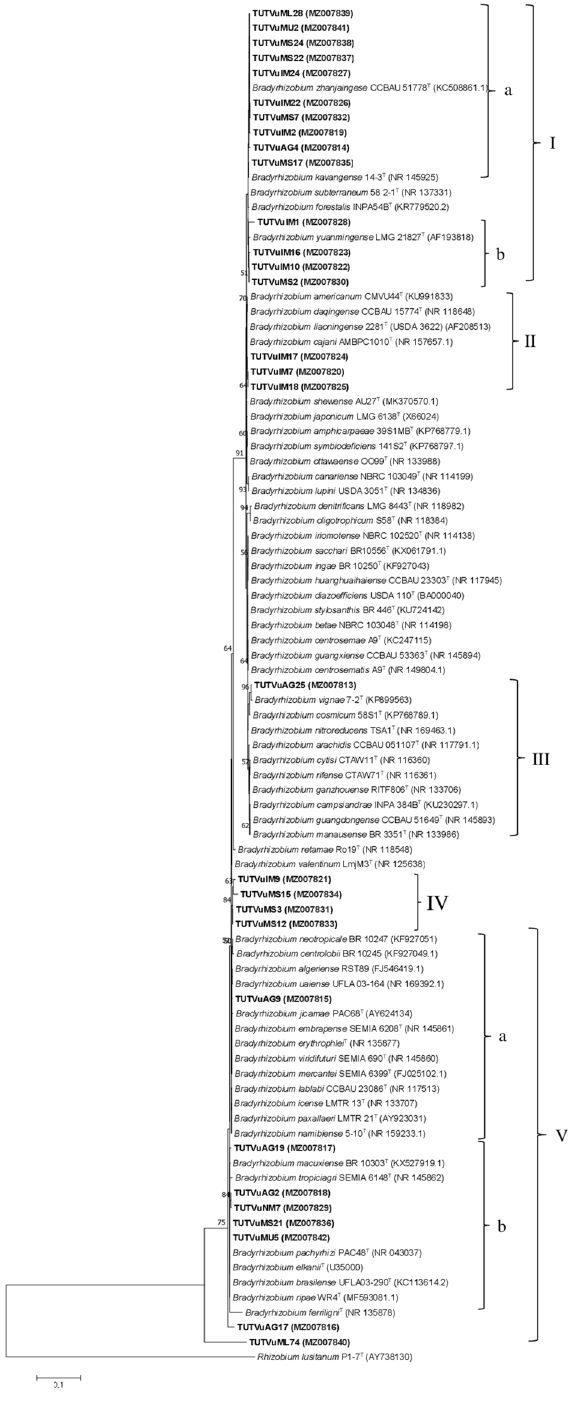
Figure 3. Maximum likelihood molecular phylogenetic analysis of native cowpea nodulating Bradyrhizobium isolates from Mozambican soils based on 16S rRNA gene sequences. The aligned sequences were trimmed to a uniform length of 958 bp for the construction of the phylogenetic tree. For each isolate and reference type strain, the accession numbers are indicated in